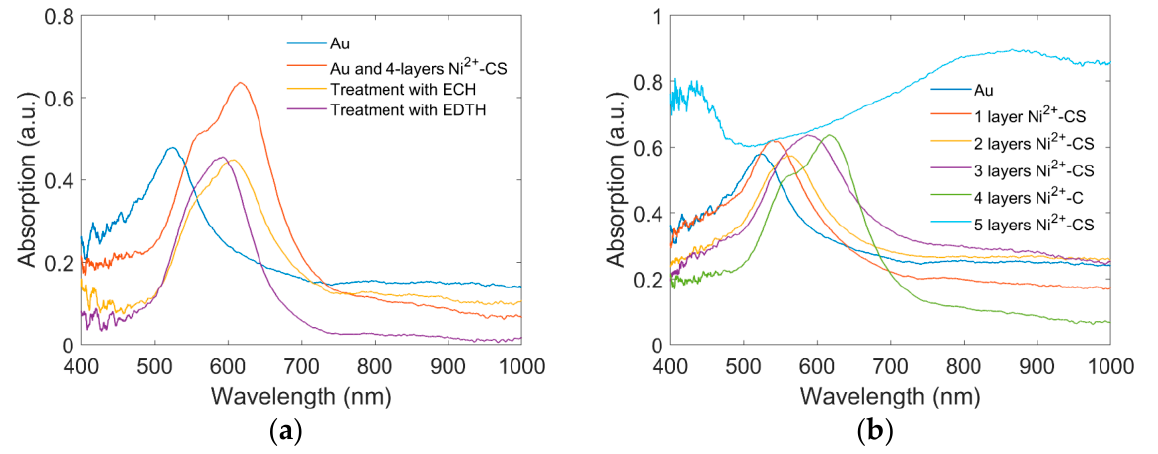
Figure 4. Absorption spectra of the LSPR sensor ( a ) in the preparing process and ( b ) with different layer chitosan gels.